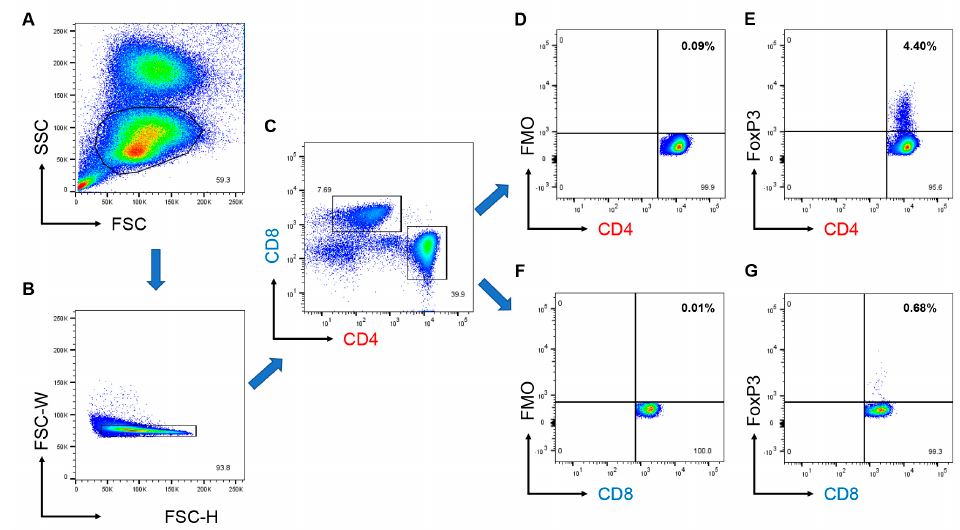
Figure 2. Gating strategy to identify CD4 + and CD8 + regulatory T cells (Tregs) using flow cytometry. ( A ) Lymphocytes from peripheral blood mononuclear cells gated using forward (FSC) and side (SSC) scatter. ( B ) Doublets were removed. ( C ) Identification of CD4 + and CD8 + T cells. ( D ) CD4 + fluorescent minus one (FMO), ( E ) CD4 + Foxp3 + cells defined as CD4 + Tregs. ( F ) CD8 + FMO, ( G ) CD8 + Foxp3 + cells defined as CD8 + Tregs.